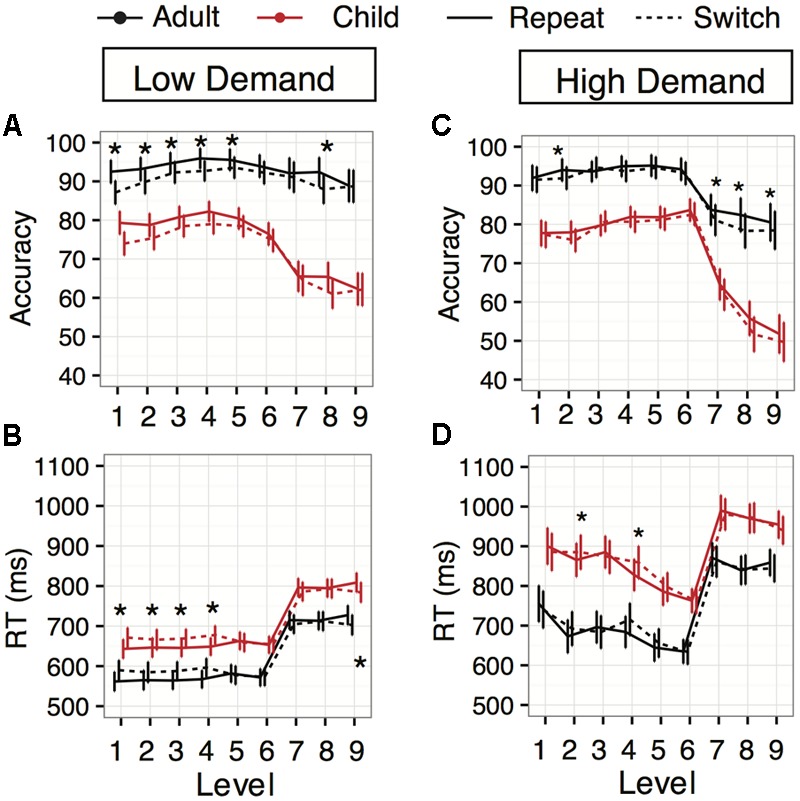
Task-switching performance across levels in Experiments 1 (Low Demand, left panels) and 2 (High Demand, right panels). (A,C) Accuracy averages plotted across the levels for repeat (dashed line) and switch (solid line) trials. Adult (blue) and child (red) data are shown. The asterisks denote levels with significant switch costs. (B,D) Response time averages for repeat and switch across the levels for adults and children (same color and line contrast). The asterisks above the data represent levels with significant switch costs (slower/less accurate than repeat trials). The Asterisk below the data represents a level with a significant switch benefit. Error bars indicate 95% confidence interval of the mean.